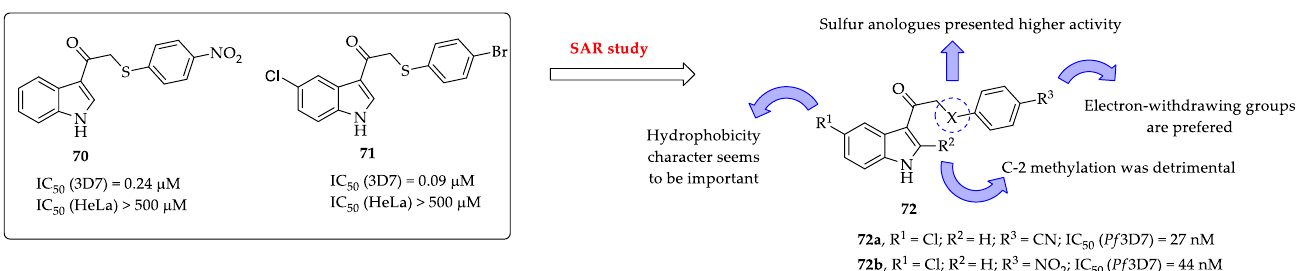
Figure 7. SAR study of indolyl-3-ethanone ethers and thioethers. Re-engineering of the indole alkaloid yohimbine ( 73 ) through ring rearrangement and ring cleavage synthesis pathways led to a new class of antiplasmodial agents (Figure 8). The most active compound ( 74d ) presented an IC 50 of 1.60 µM against chloroquine-resistant P. falciparum Dd2 strain and was selective over HepG2 cells (CC 50 = 18.9 µM) [70].